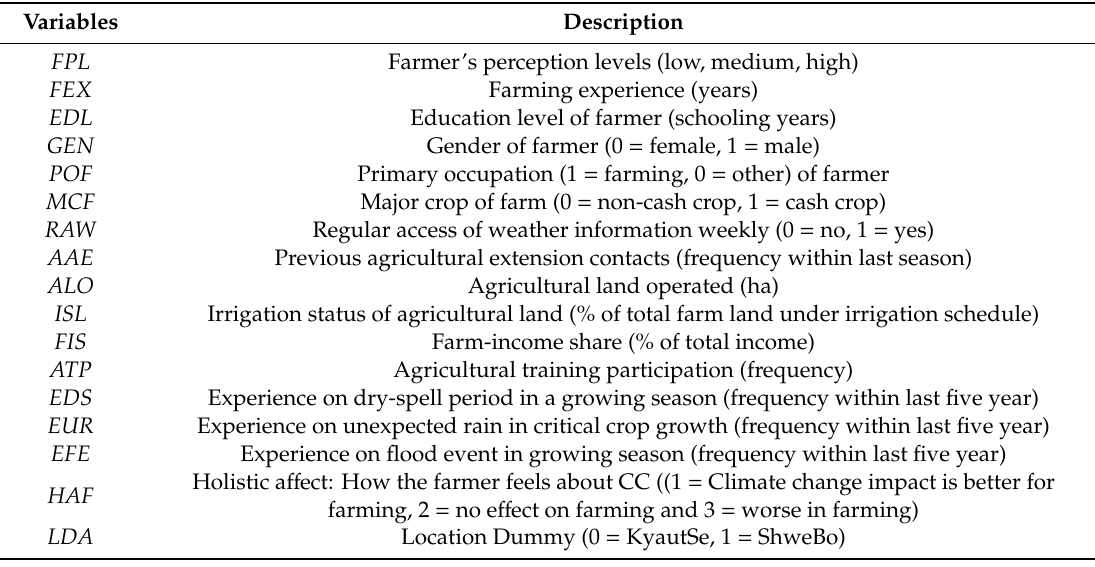
Table 2. Definition of variables of farmer perception model.